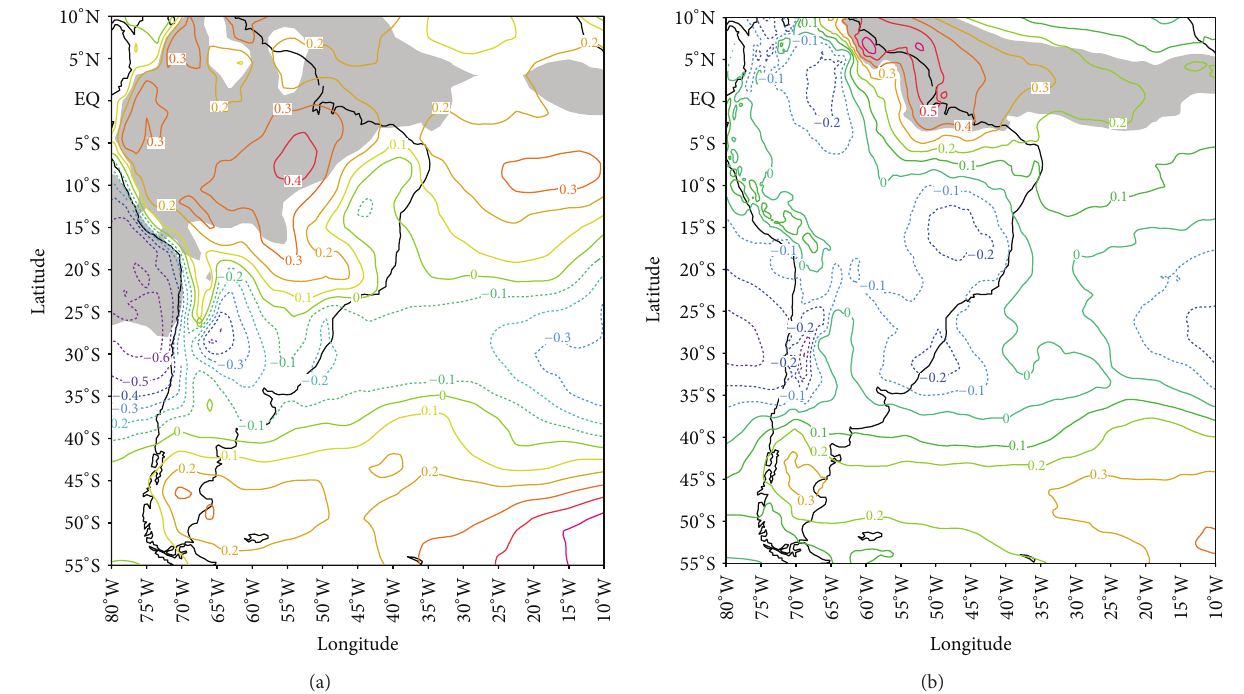
Figure 9: Annual mean temperature (K) anomaly at 850 hPa for HCSA strong cases in the period 1996–2011 based on the (a) Era-Interim reanalysisand(b)RegCM4simulation.Contourintervalsare0.1 Kandsignificantvaluesabove90%confidencelevelfromtwo-tailedStudent’s 𝑡 -test are shaded.